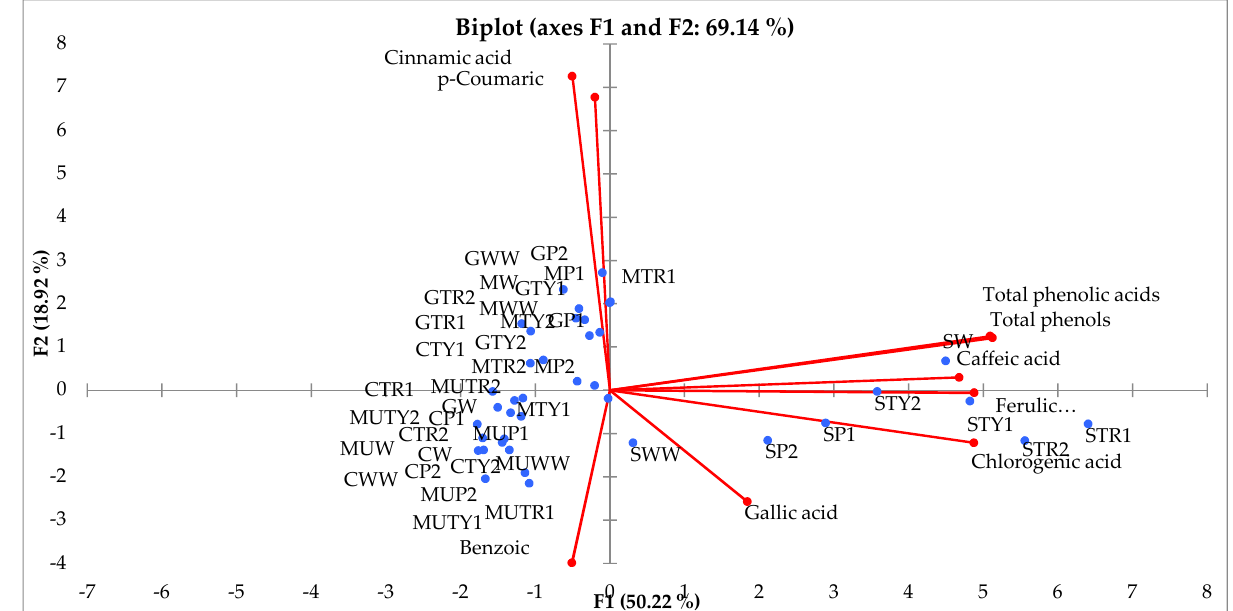
Figure 3. Principal-component analysis (PCA) for total phenolic, total phenolic acids content, amount of phenolics acids of different varieties of mints influenced by different amino acids and its concentrations (MW— M. spicata “Moroccan” water,